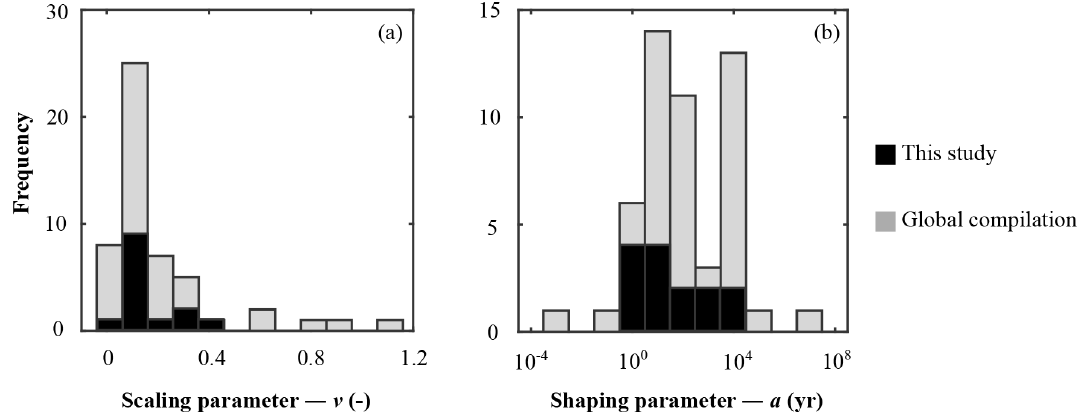
Figure 4. Frequency histogram of organic matter reactivity parameter distribution on a global scale: (a) scaling parameter – v ; (b) shaping parameter – a . Table 4. Site-specific transport parameters and upper boundary conditions implemented in the reaction–transport